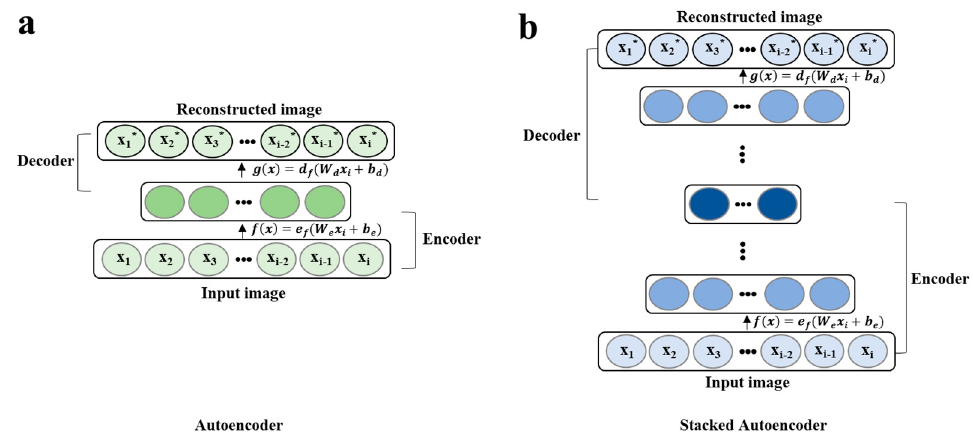
Figure 2. Neural network structure: ( a ) autoencoder with encoder and decoder and deep neural network structure; ( b ) stacked autoencoder with multiple encoders and decoders. Rectangular boxes and circles represent the internal hidden layers and nodes, respectively.